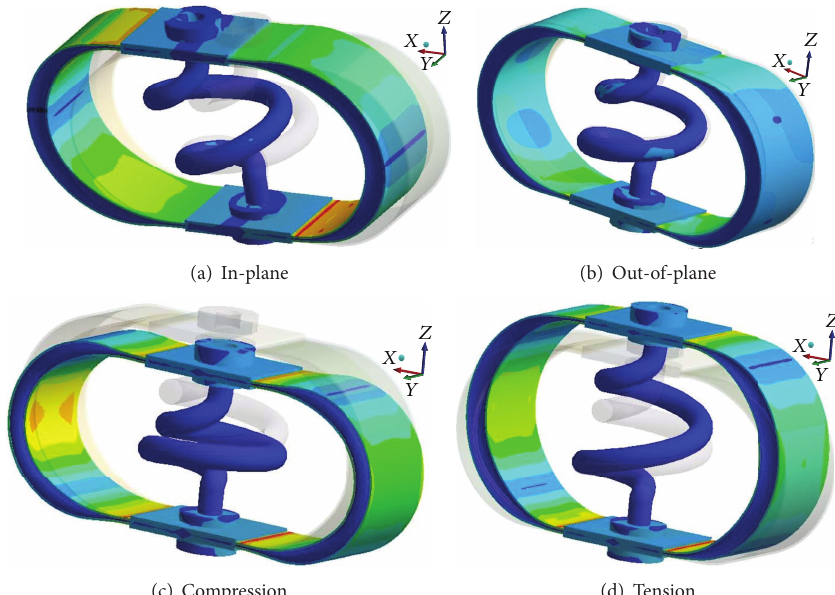
Figure 3: Deformed shapes of LRELS